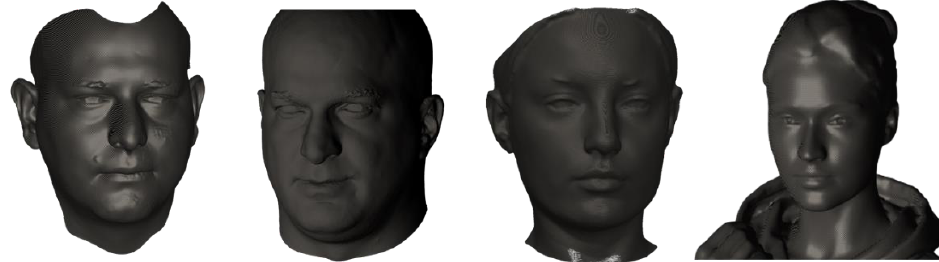
Figure 4. Virtual models of two male ( left ) and two female ( right ) individuals.